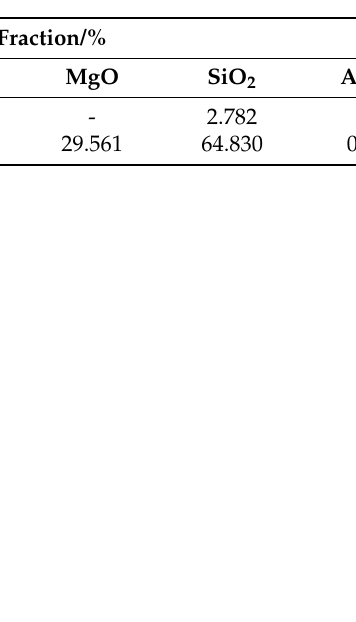
Figure 1. XRD patterns of pure chalcopyrite ( a ) and talc ( b ) samples. Table 1. Chemical composition of chalcopyrite and talc.